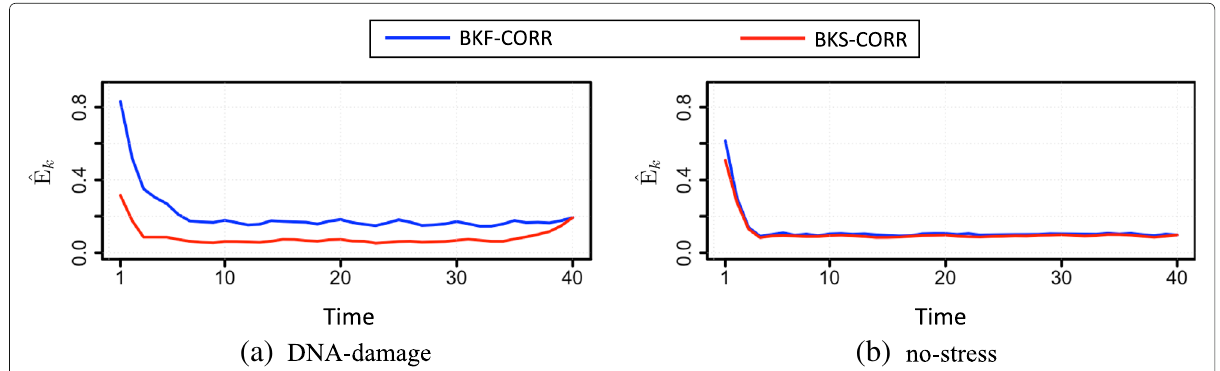
Fig. 5 Average correct state estimation rates for the BKF-CORR and BKS-CORR estimators under a DNA-damage and b no-stress